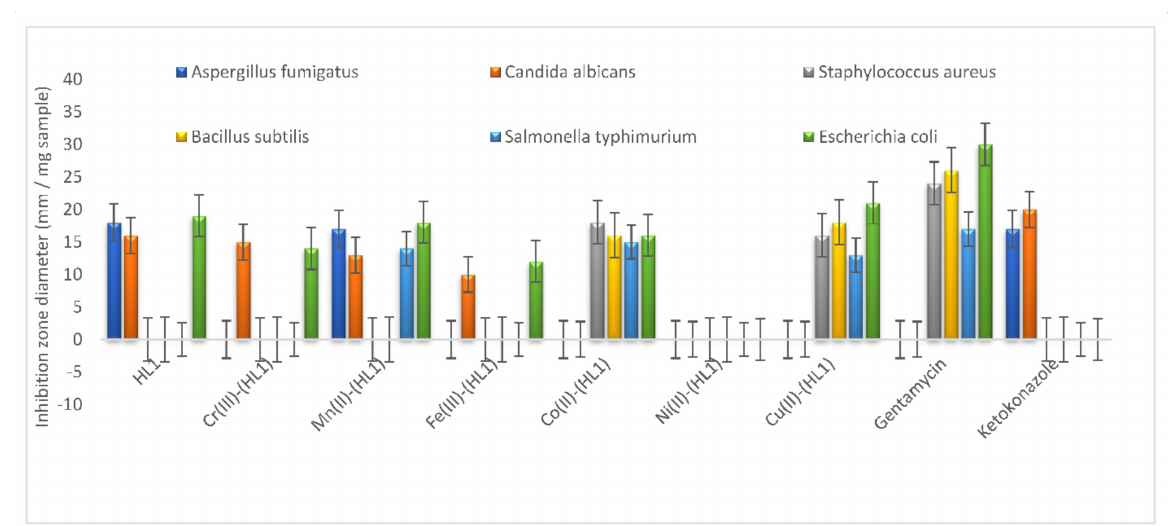
Figure 5. Biological efficiency of HL and its metal